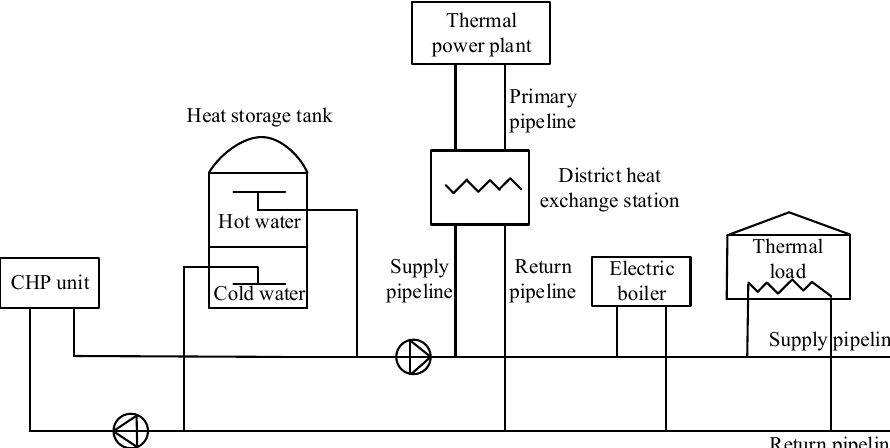
Figure 2. Structure of thermal energy system.